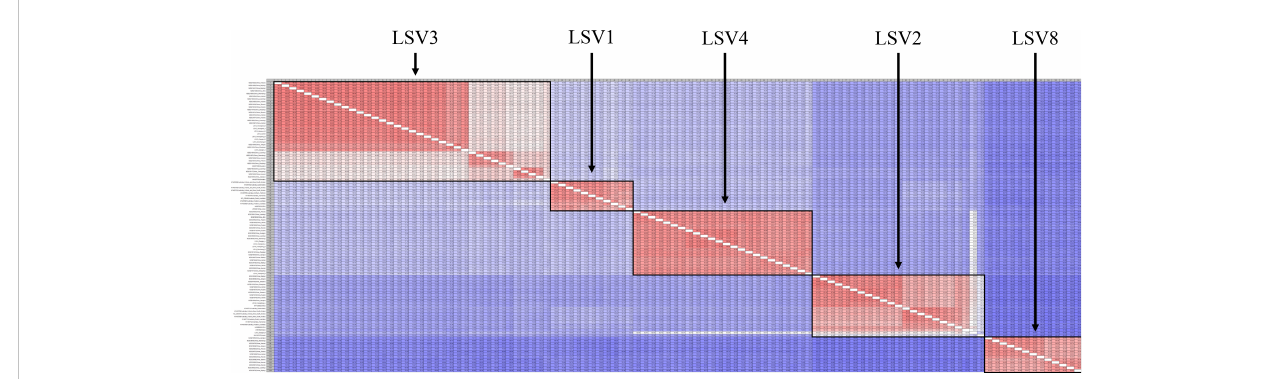
FIGURE 4 Pairwise comparison table using RNA-dependent RNA polymerase (RdRp) region among Lake Sinai virus 1, 2, 3, 4 and 8 (LSV1, 2, 3, 4, and 8) complete sequences for each country reported to NCBI GenBank database using CLC Genomics Workbench. Percent identity in 11,664 pairwise comparisons among 108 sequences (15 sequences detected in this study and 93 sequences reported from NCBI GenBank